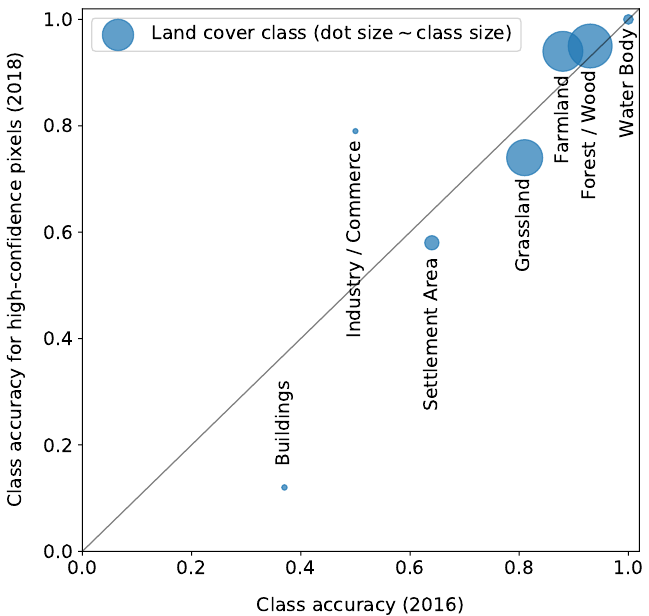
Figure 11. Calibration plot for the best-scoring ensemble of LSTM F models. The accuracy per class of the 2018 classification for high-confidence pixels is shown over the accuracy of each class from the 2016 classification (see Figure 8). The size of each class dot corresponds to the number of pixels of each class (see Table